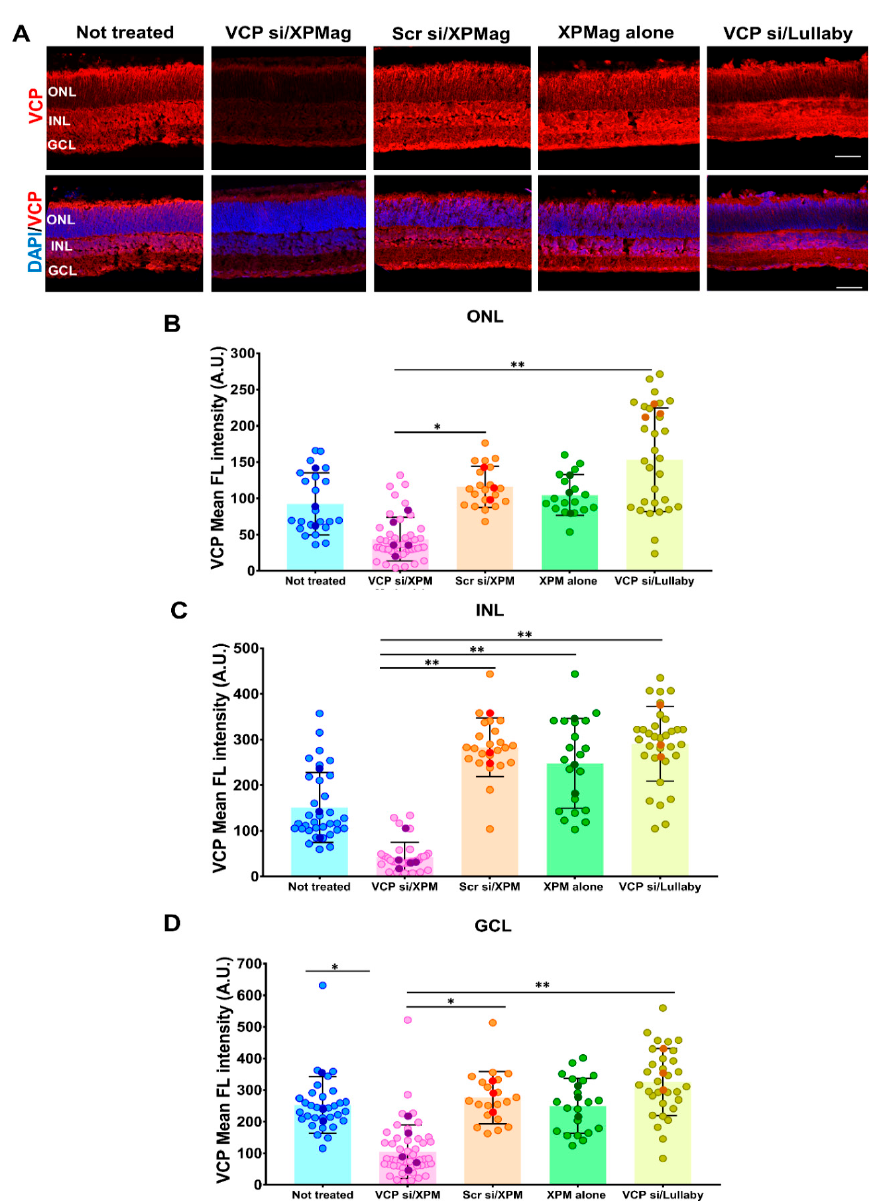
Figure 4. Efficient gene silencing of VCP in RHO P23H rat retinal organotypic culture by Reverse Magnetofection through the entire layers of the retinal explant at 72 h after treatment. Retinae of RHO P23H transgenic rats were explanted on the postnatal day 12 and cultured for three days. Retinae were treated with 50 nM VCP si/XPMag, 50 nM Scr si/XPMag, and XPMag alone by Reverse Magnetofection and VCP si/Lullaby by lipofection. ( A ) Explants were stained with specific VCP antibody (red) using nuclei counterstaining with DAPI (blue). ( B – D ) Quantification of VCP immunofluorescence intensity in the ONL, INL and GCL. For each layer, a complete region of each image was selected, and the mean fluorescence intensity was assessed using the Zen 3.2 software. Bar graph shows the mean fluorescent intensity in ( B ) ONL, ( C ) INL, and ( D ) GCL upon Reverse Magnetofection of VCP siRNA/XPMag as compared to control conditions. A significant decrease in VCP signal intensity in all three different layers after Reverse Magnetofection of VCP siRNA/XPMag compared to the other groups. Scale bar 50 µ m. The values were quantified by evaluating multiple images (circles) from three retinae ( n = 3) per treatment for not treated, Scr si/XPMag, XPMag alone, and VCP si/Lullaby groups, five retinae ( n = 5) per treatment for VCP si/XPMag group. Data are presented as mean ± SD, and one-way ANOVA analysis was performed at * p < 0.05 and ** p < 0.01. The error bars correspond to the standard deviation. Abbreviations: VCP si: VCP siRNA, Scr si: scrambled siRNA, XPM: XPMag, FL: fluorescence, ONL: outer nuclear layer, INL: inner nuclear layer, and GCL: ganglion cell